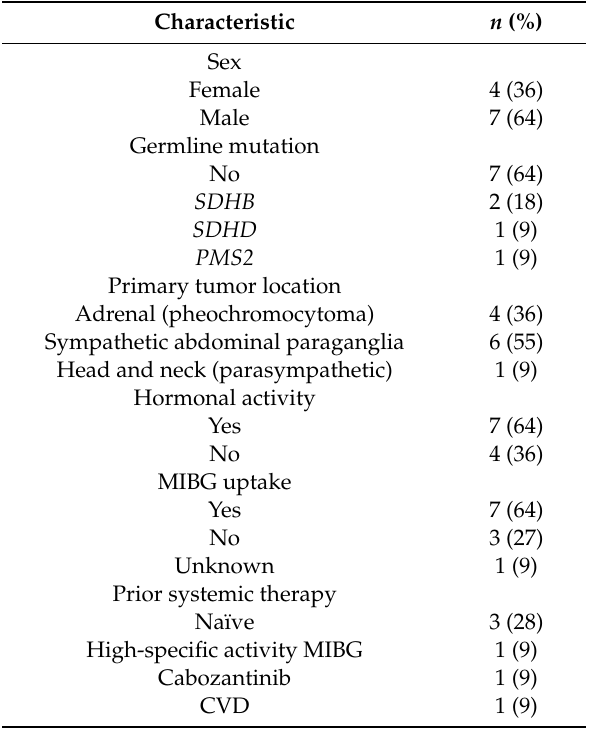
Table 1. Patient